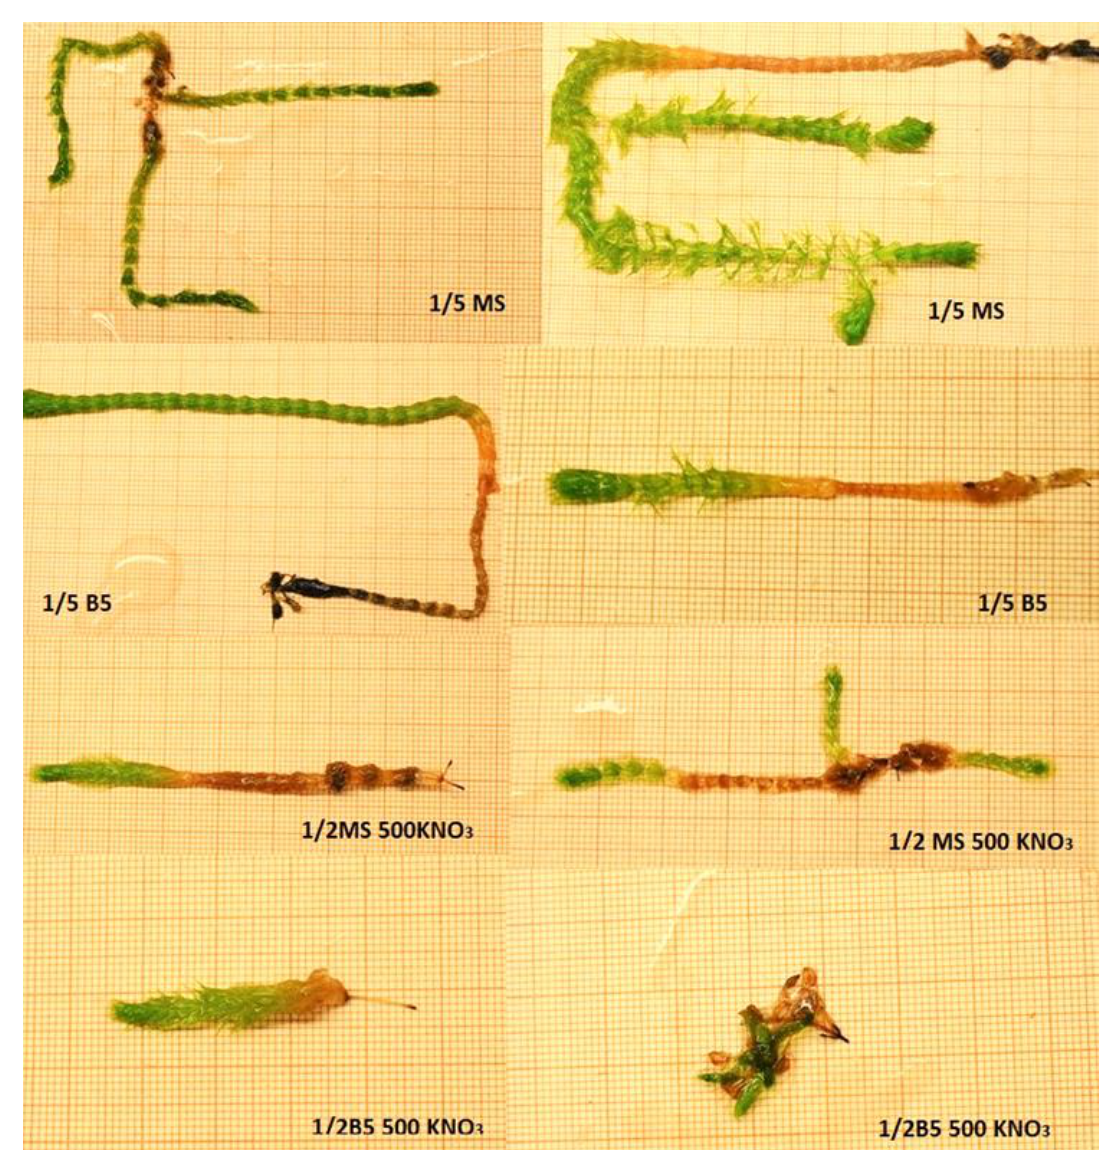
Figure 7. Shoots of Aldrovanda vesiculosa depending on the media type in tissue culture.